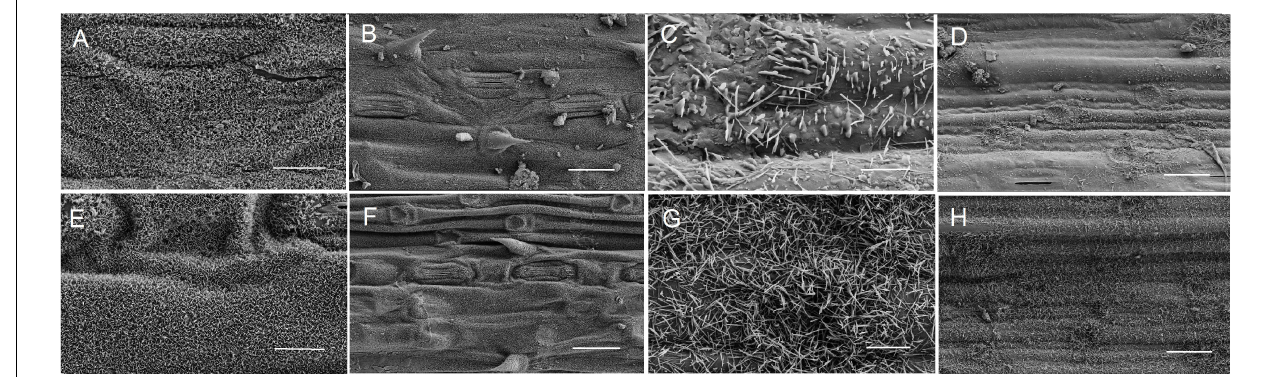
FIGURE 1 | Epicuticular wax crystals on the surfaces of flag leaves from non-glaucous DHs (A–D) and glaucous DHs (E–H) detected by scanning electron microscope (SEM). (A,B,E,F) Adaxial surface of flag leaf. (C,D,G,H) Abaxial surface of flag leaf. Panels (A,C,E,G) were assessed at 10,000 × magnification, Scale bars = 2 µ m; Panels (B,D,F,H) were assessed at 2,000 × magnification, Scale bars = 10 µ m.